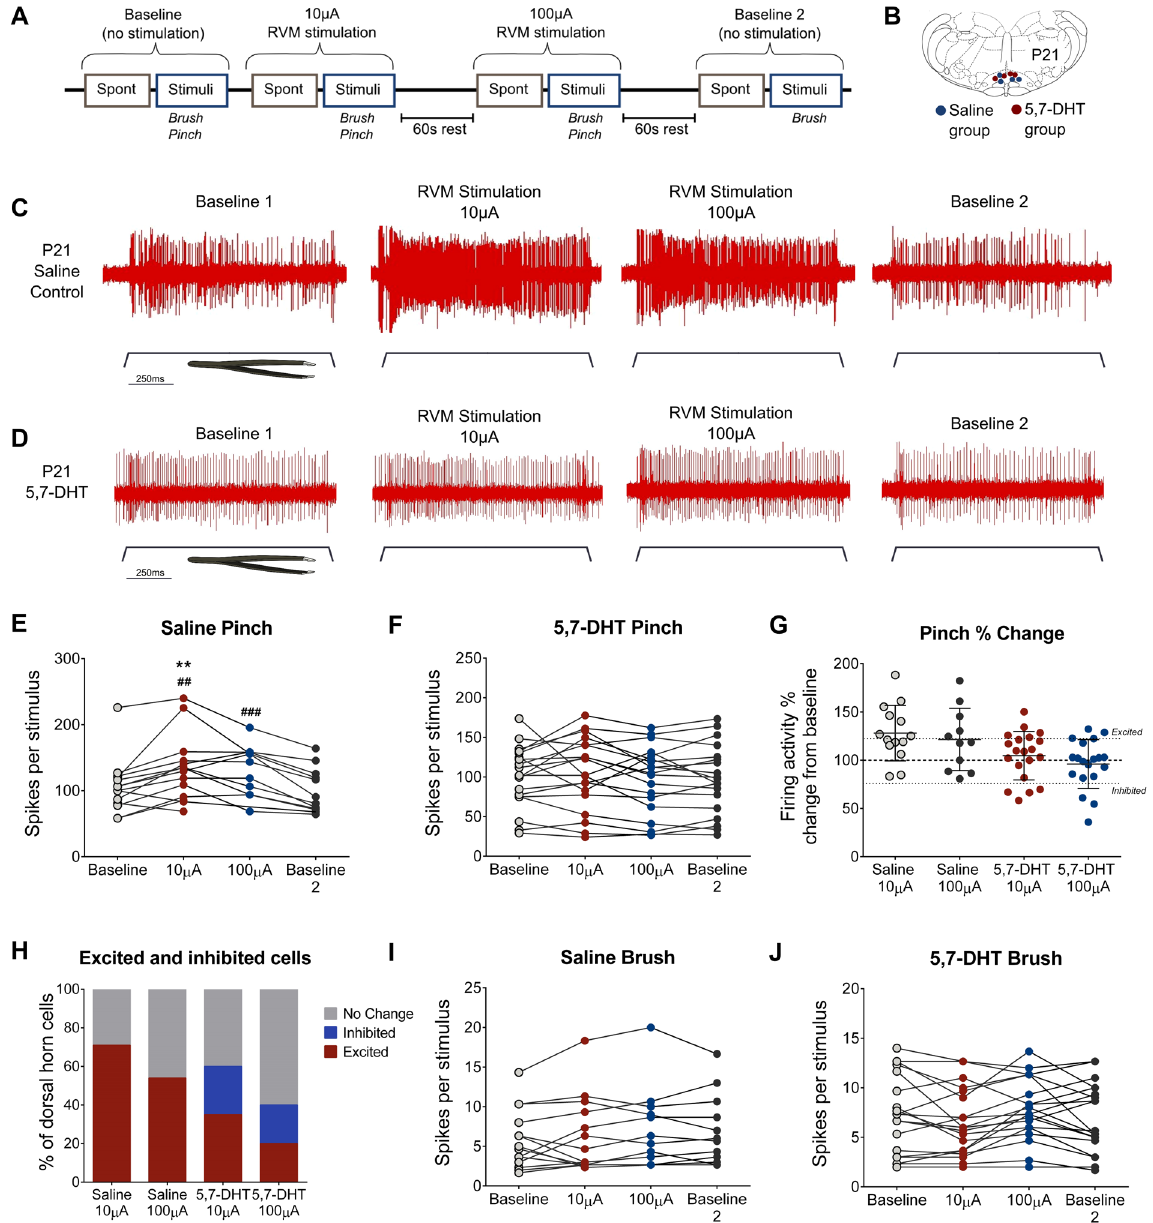
Figure 5. RVM stimulation facilitates dorsal horn neuron activity at P21, but not following ablation of serotonergic terminals. ( A ) Timeline of experiments: brush and pinch-evoked dorsal horn neuron activity was recorded at baseline, during 10 μ A stimulation, and during 100 μ A stimulation of the RVM. RVM stimulation electrode sites are shown in ( B ). Typical traces of pinch-evoked dorsal horn neuron activity during RVM stimulation bouts are shown in a saline control rat ( C ) and a 5,7-DHT treated rat ( D ). 10 μ A and 100 μ A RVM stimulation facilitated mean pinch-evoked firing activity in saline-treated rats ( E ), but not 5,7-DHT treated rats ( F ). RVM stimulation increased pinch-evoked firing activity relative to baseline in many individual neurons in saline-treated rats, but not in 5,7-DHT-treated rats ( G ). RVM stimulation increased pinch evoked activity in the majority of cells ( > 20% firing activity relative to baseline pinch) in saline-treated rats upon ( H ), while in 5,7- DHT treated rats, pinch evoked activity was reduced in a subset of cells ( < 20% firing activity relative to baseline pinch) by RVM stimulation ( H ). RVM stimulation did not change mean brush-evoked firing activity in saline ( I ) or 5,7-DHT-treated rats ( J ). Bars indicate mean ± SEM. ** P < 0.01 versus baseline 1; ##,### P < 0.01, 0.001 versus baseline